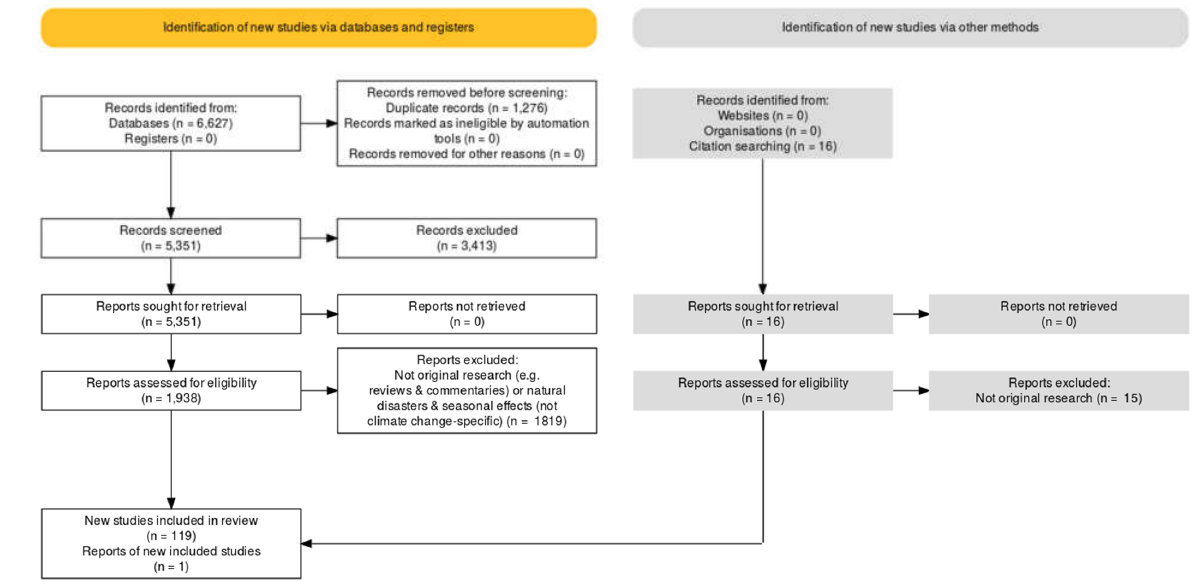
Figure 1. PRISMA flow diagram of study selection.